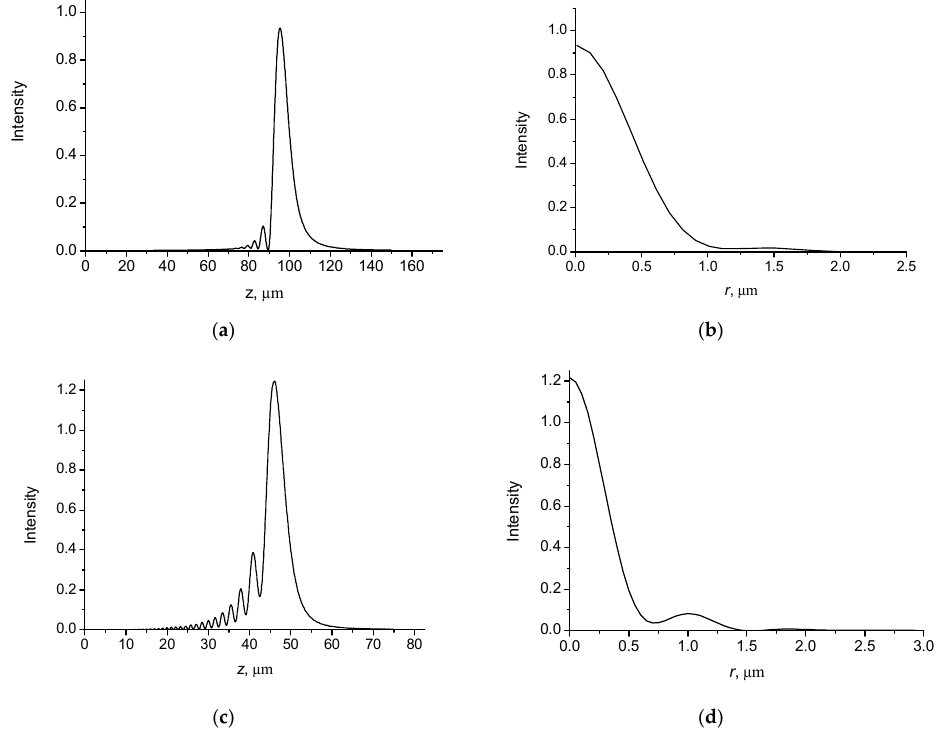
Figure 6. Intensity distributions of focused Gaussian beams in axial direction and radial direction at focus planes: ( b ) z f = 95.3 µm; ( d ) z f = 46.0 µm. Incident beams with w = 30 µm , λ = 0.63 µm and R f = 100 µm ( a , b ) and R f = 50 µm ( c , d ).